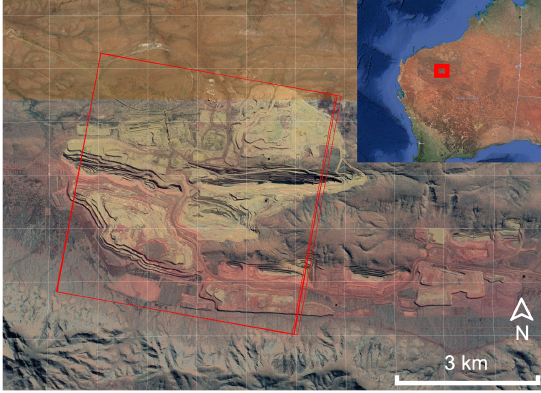
Figure 4. Coverage of imagery from Capella Space over the West Angelas Mine; area in western Australia shown in inset.